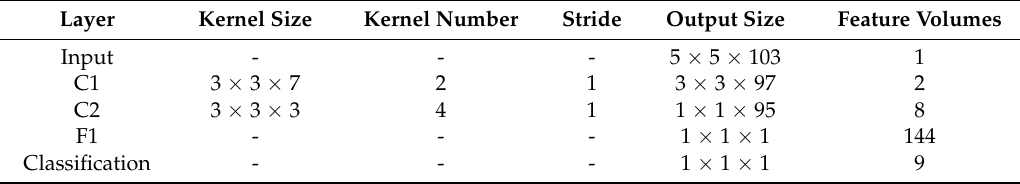
Table 4. Architecture of 3D-CNN in Pavia University scene.